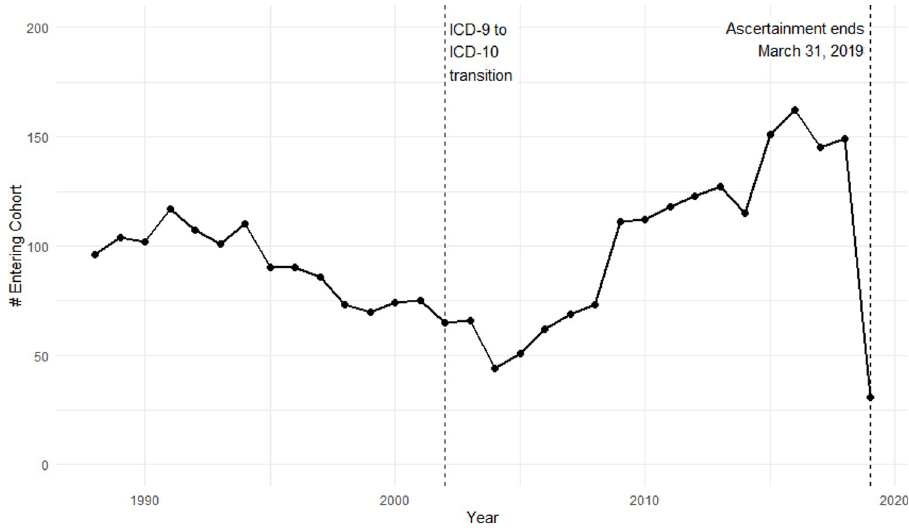
Fig 2. Frequency of mitochondrial disease by year of entry into study cohort, 1988 to 2019. 2019 is incomplete because of study termination on March 31, 2019.